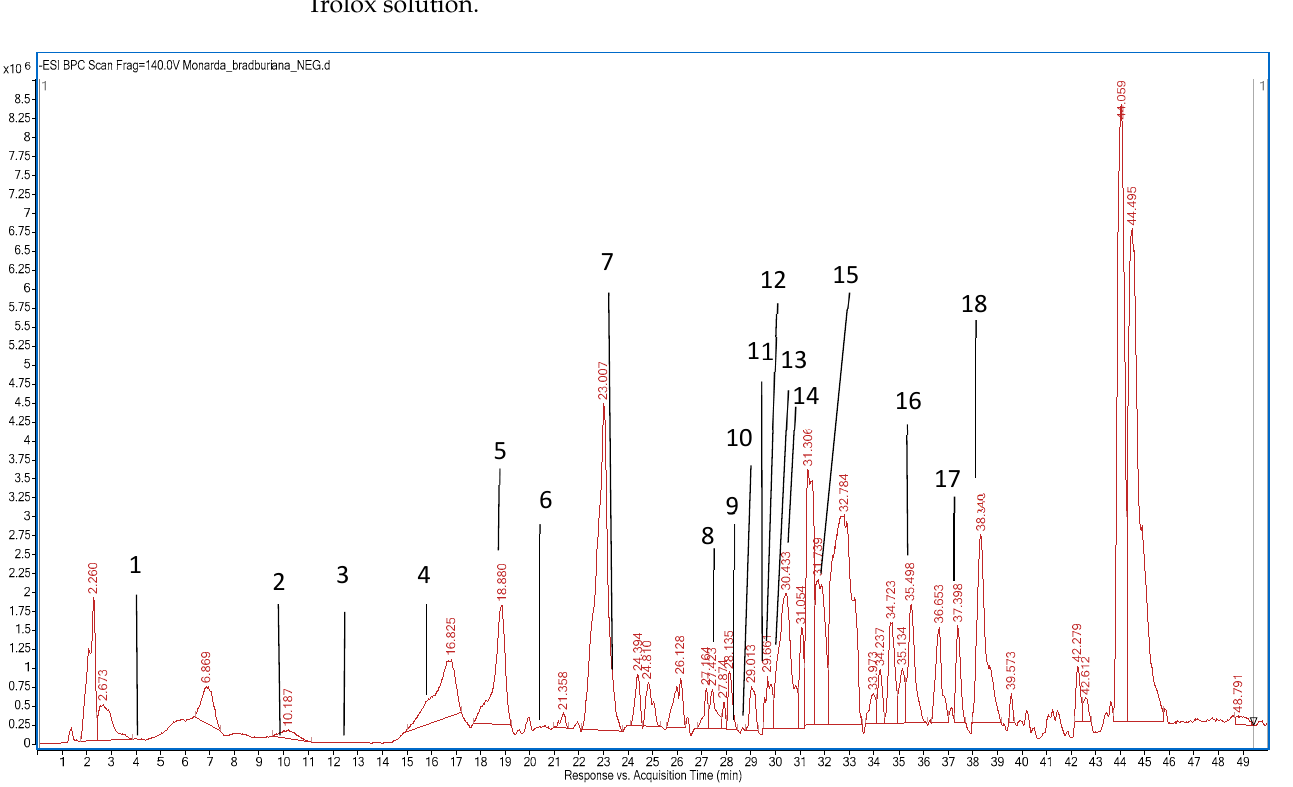
Figure 1. The HPLC–ESI-QTOF-MS/MS total ion current chromatogram of the 70% ( v/v ) methanolic extracts from flowering herbs of M. bradburiana : 1. gallic acid, 2. protocatechuic acid, 3. hydroxyben- zoic acid glucoside, 4. p -OH-benzoic acid, 5. chlorogenic acid, 6. coumarylquinic acid, 7. p -coumaric